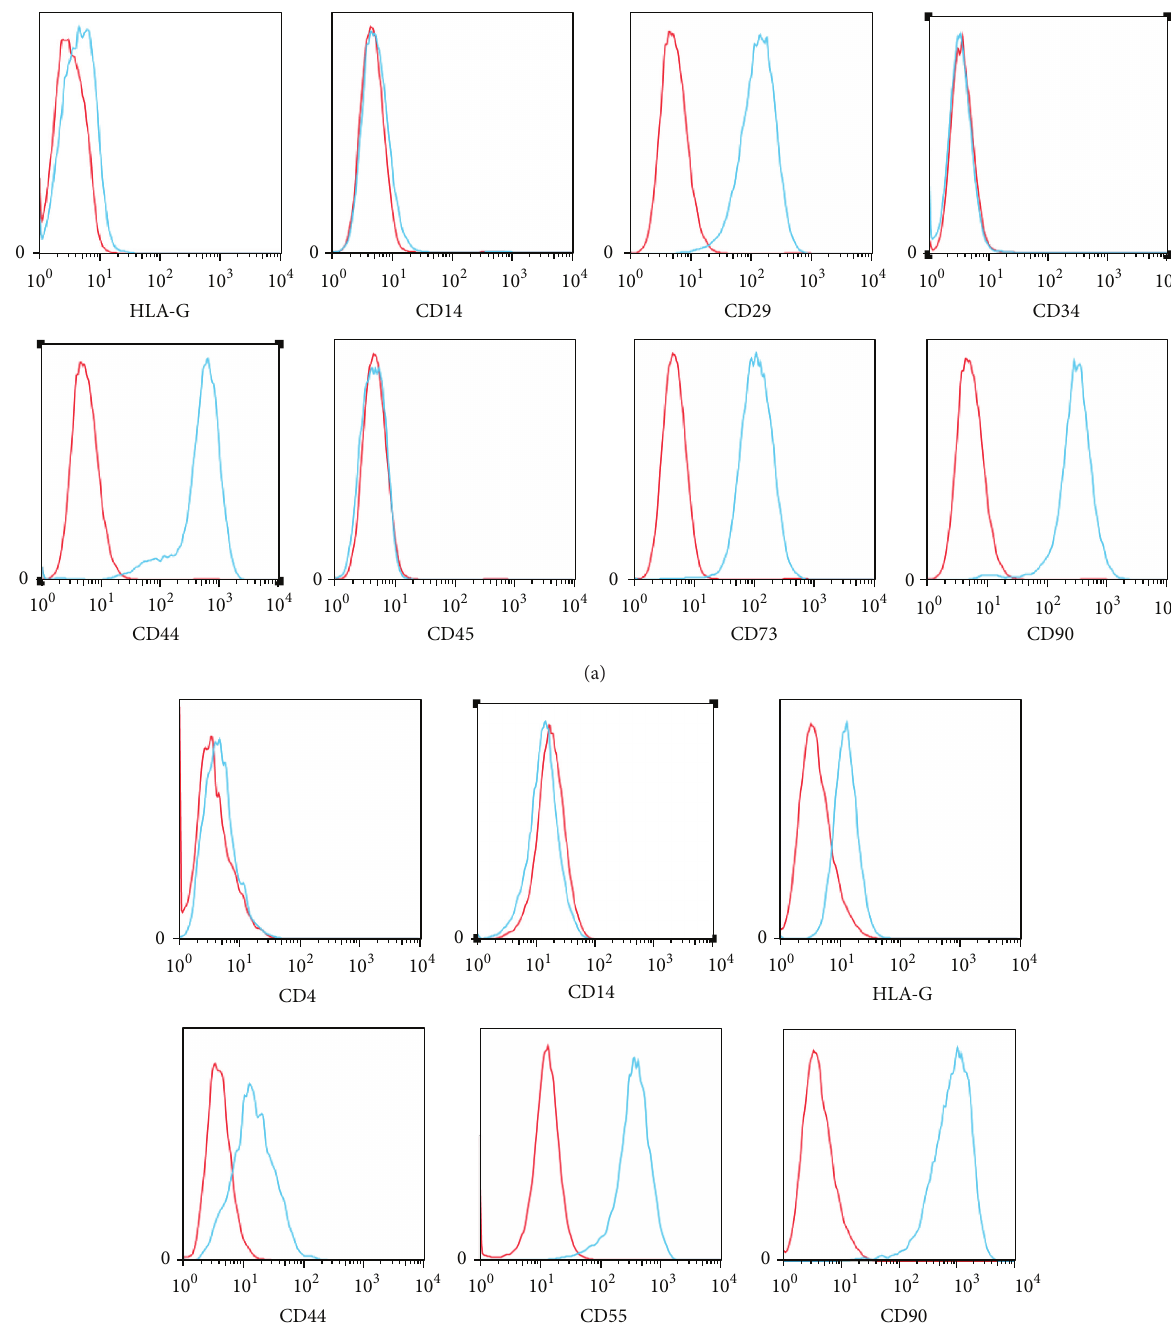
Figure 1: Identification of UCMSC and FLS. (a) Expression of the UCMSC markers: HLA-G, CD14, CD29, CD34, CD44, CD45, CD73, and CD90. (b) Expression of FLS markers: HLA-G, CD4, CD14, CD55, CD44, and CD90.